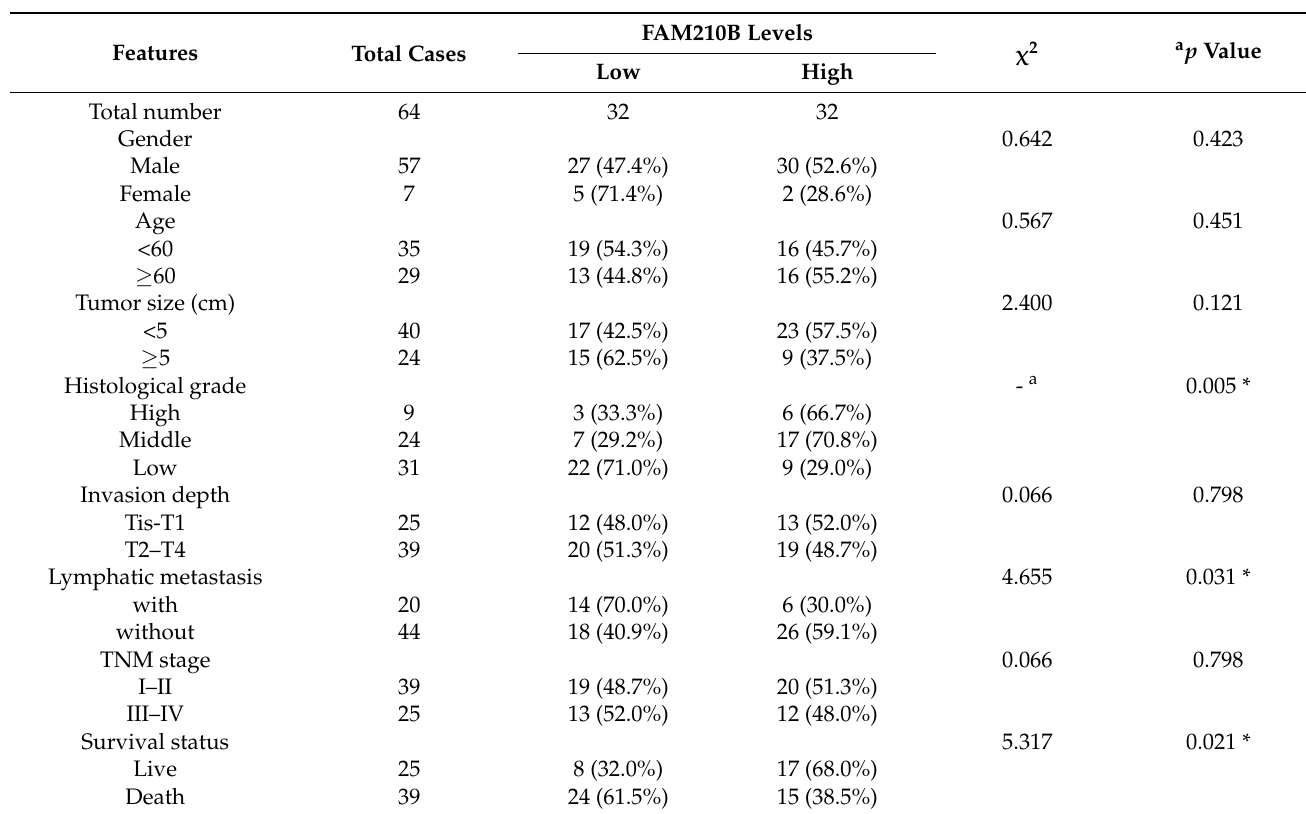
Table 1. Correlation between FAM210B protein levels and clinicopathological parameters in 64 HCC